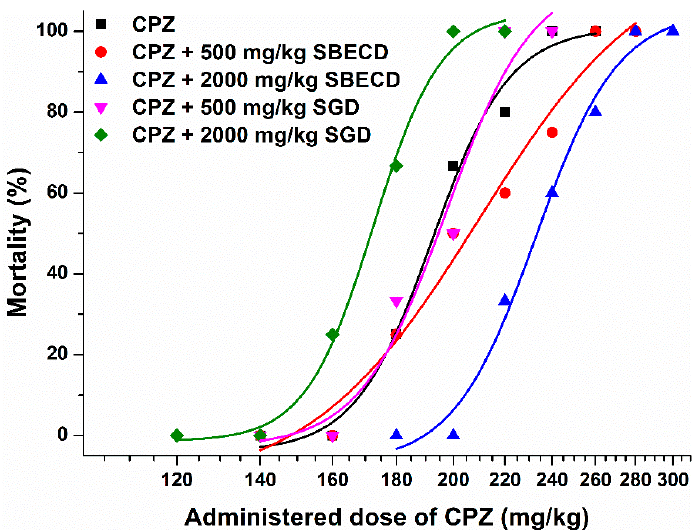
Figure 5. CPZ-induced 24 h mortality without and with SBECD or SGD co-treatment. NMRI mice were treated with CPZ (i.p. 120–300 mg/kg), after which SBECD or SGD (i.v. 500 or 2000 mg/kg; or physiological saline in control animals) was administered (see Section 2.3.). Table 1. LD 50 values calculated employing the Probit Analysis based on the 24 h mortality data of female NMRI mice.